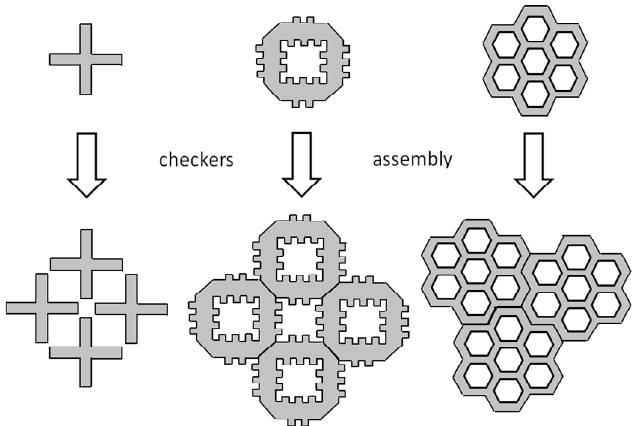
Figure 1. Examples of checker brick sections and their